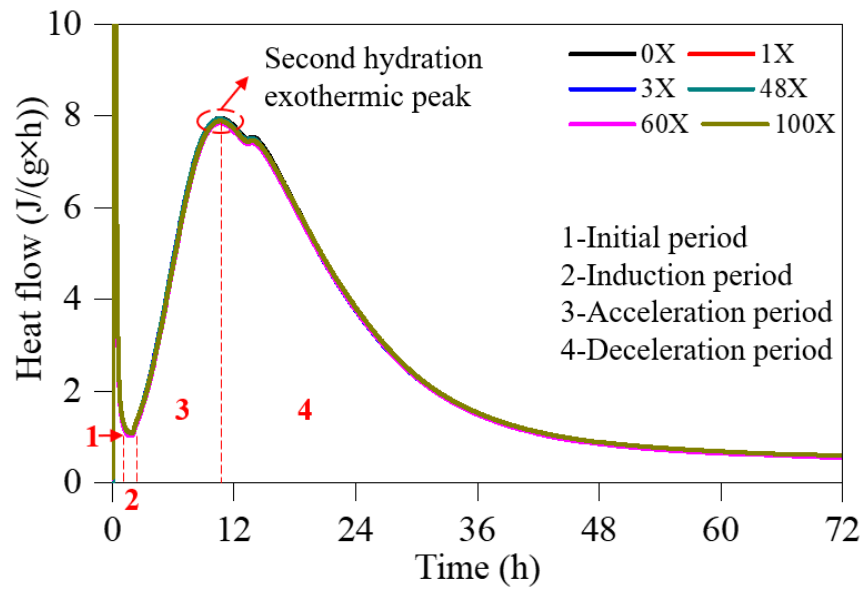
Figure 7. Evolution of heat release rate from 0 to 72 h with different contents of the CTF. Figure 8a shows the first hydration exothermic peak for each specimen. The first exothermic peak is due to the quick dissolution of aluminate and sulfate [39]. After about 3 min, all specimens, all with different CTF contents, reached the first exothermic peak, but the rate of exothermic heat generation varied greatly for each specimen. At the first peak, the differences in the rate of heat generation between the pure cement specimen and specimens 1X, 3X, 48X, 60X and 100X were 12.0, 30.0, 21.3, 56.7, and 52.0%, respectively. This indicates that the CTF can promote the dissolution of cement and the hydration of C 3 A in the early stage, and the higher the content of CTF, the faster the rate of hydration heat release. However, increasing the amount of CTF does not proportionally increase the hydration heat release